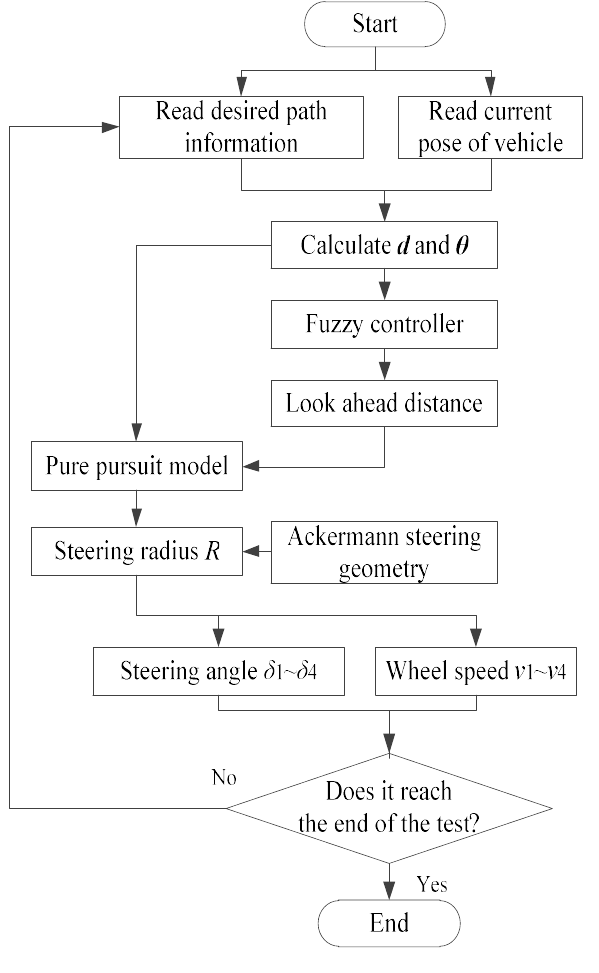
Figure 3. Fuzzy control